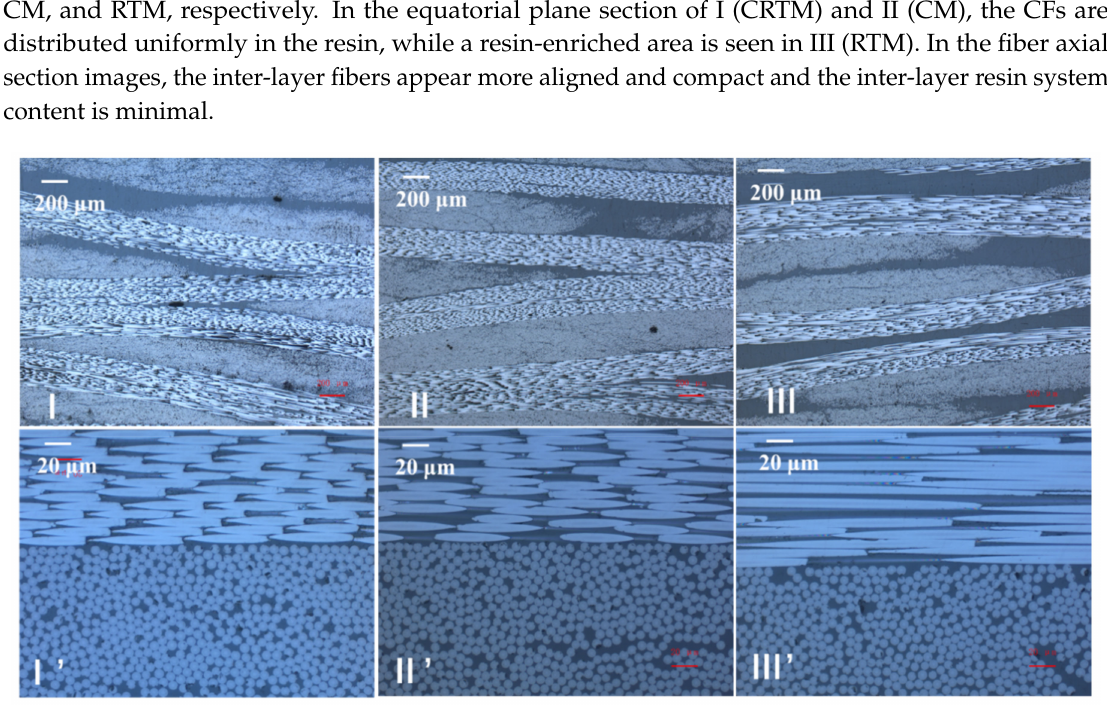
Figure 11. Microstructure of composite samples prepared by different molding methods: (I, II, and III) fiber equatorial plane section (scale: 200 µ m) and (I’, II’, and III’) fiber axial section (scale: 20 µ m) of composites prepared by CRTM, CM, and RTM, respectively.